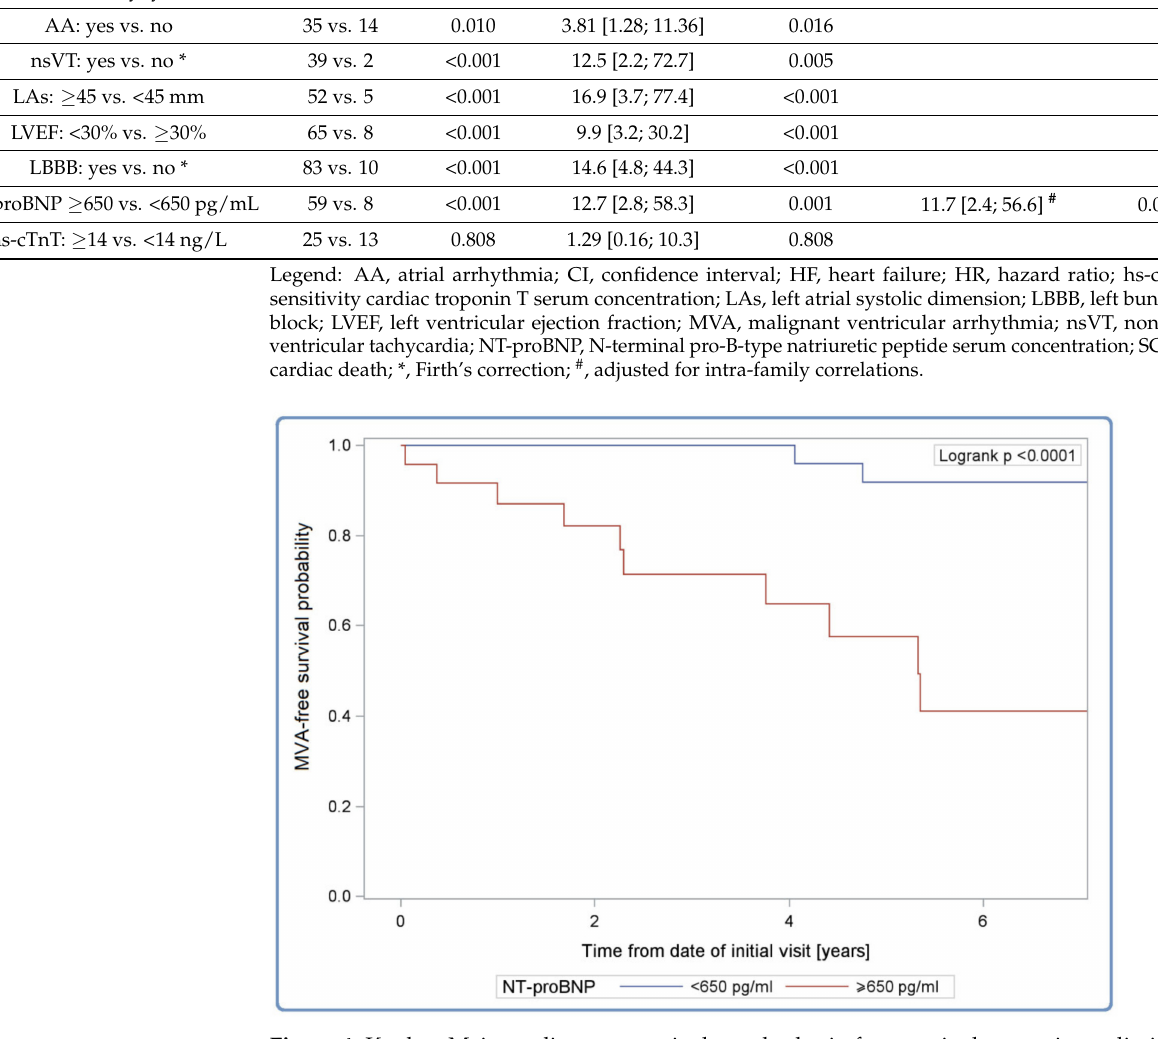
Figure 4. Kaplan–Meier malignant ventricular arrhythmia-free survival curves in cardiotitinopathy according to NT-proBNP serum concentration. Legend: MVA, malignant ventricular arrhythmia; NT-proBNP, N-terminal pro-B-type natriuretic peptide serum